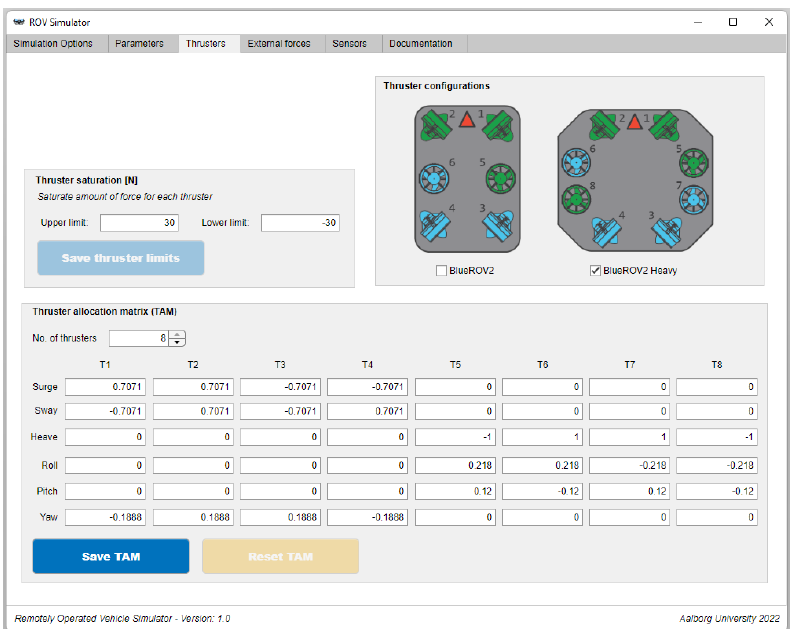
Figure A4. Overview of the thruster parameters pane within the ROV simulator